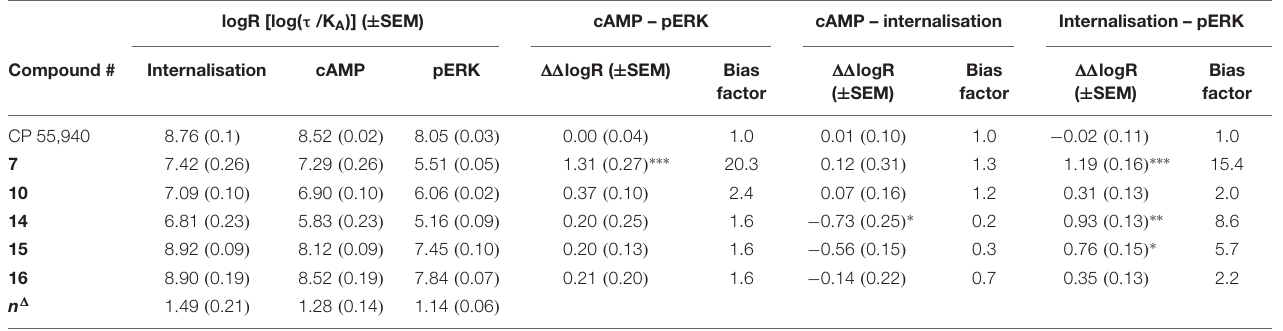
TABLE 3 | Signalling pathway transduction ratios (logR) and transducer function slopes (“ n ”), with between-pathway delta–delta transduction ratios ( (cid:49)(cid:49) logR) and bias factors relative to reference ligand CP 55,940. logR [log( τ /K A )] ( ±